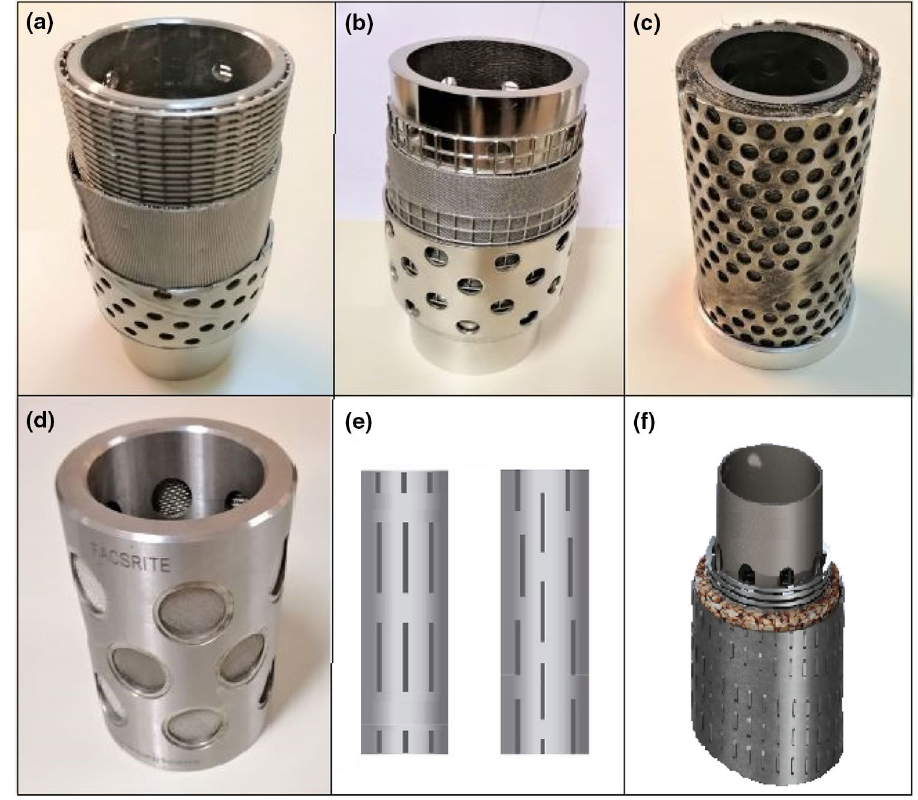
Fig. 1 Different types of stand- alone screens a and b premium screens with multiple layers; c wire-wrapped screen, d basic screen; e slotted liner and f prepacked screen.